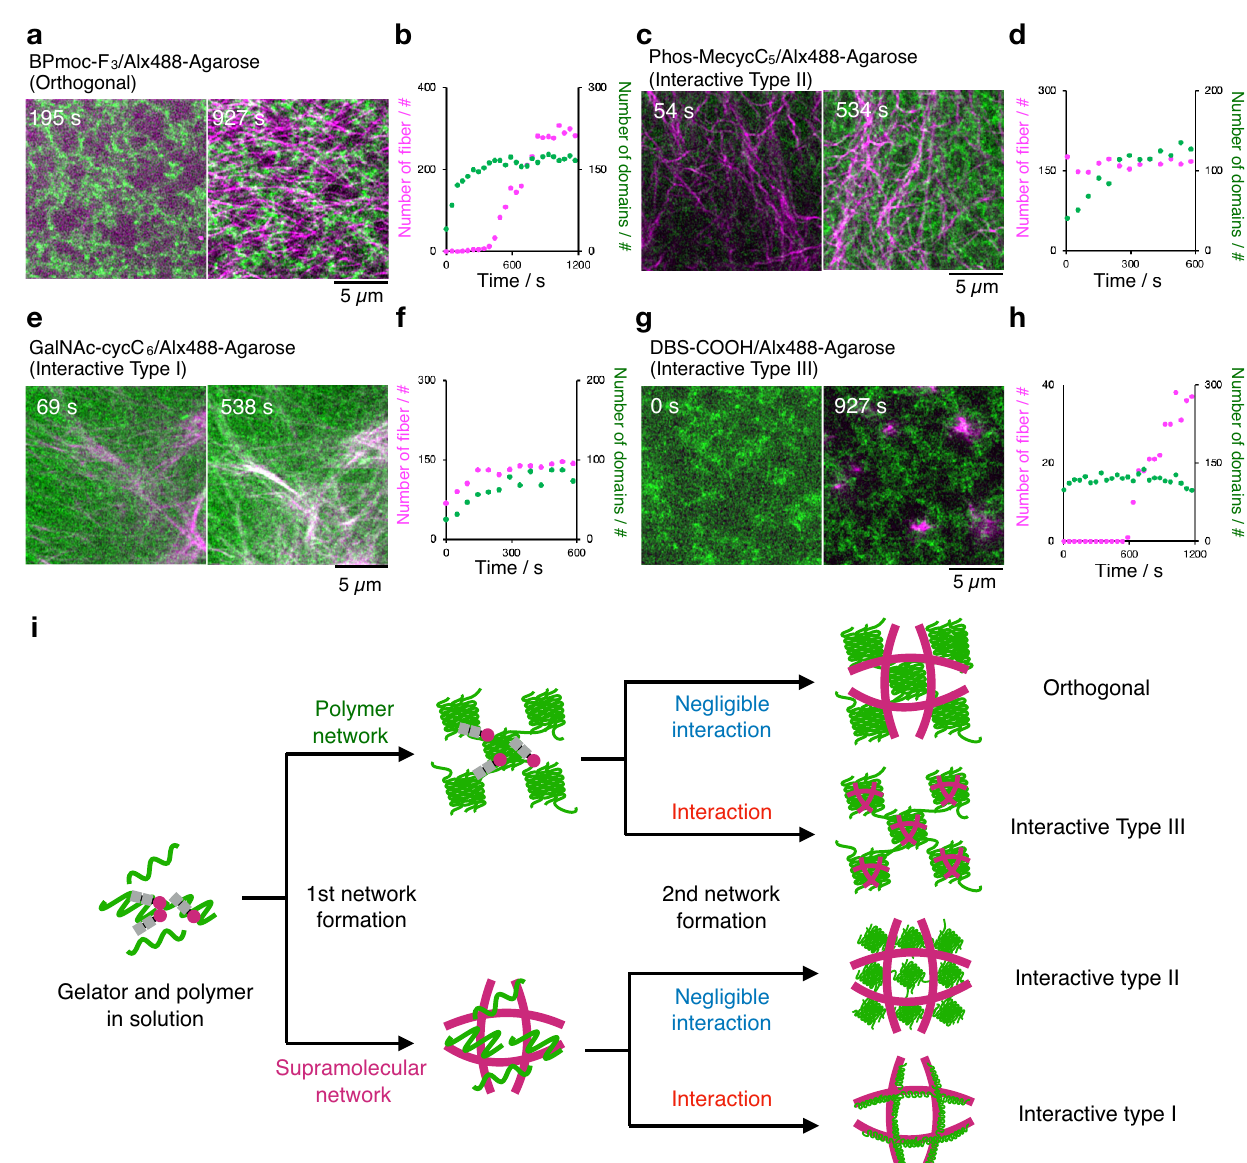
Fig. 4 | Factors controlling the network pattern formation revealed by real- time CLSM imaging. Time-lapse images of a BPmoc-F 3 /Alx488-Agarose, c Phos- MecycC 5 /Alx488-Agarose, e GalNAc-cycC 6 /Alx488-Agarose, and g DBS-COOH/ Alx488-Agarose. Magenta: supramolecular network, green: agarose network. b , d , f , h The quantitative analysis ofthe network formation. Magenta:the number of supramolecular nano fi bers counted by the particle analysis, green: the number